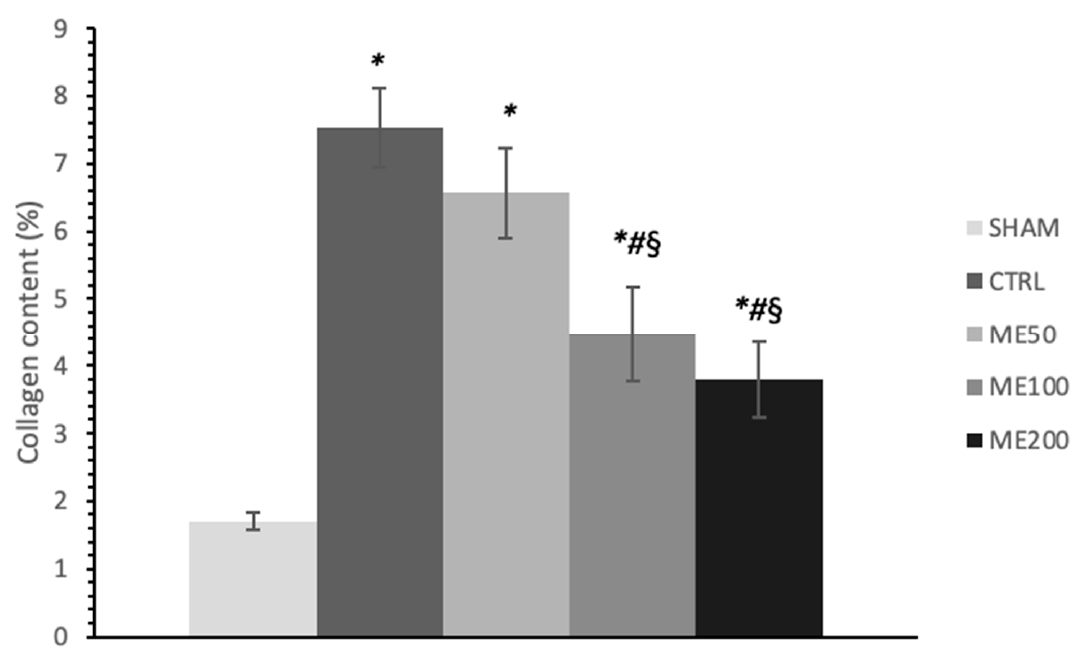
Figure 6. Effects of short-term heart preconditioning with ME on heart tissue collagen content ex- pressed in percentage ±. Values are expressed as means ± standard deviation ( n = 8). *—statistical significance at the level of p < 0.05 compared to SHAM; #—statistical significance at the level of p < 0.05 compared to CTRL; §—statistical significance at the level of p < 0.05 compared to ME50 group.